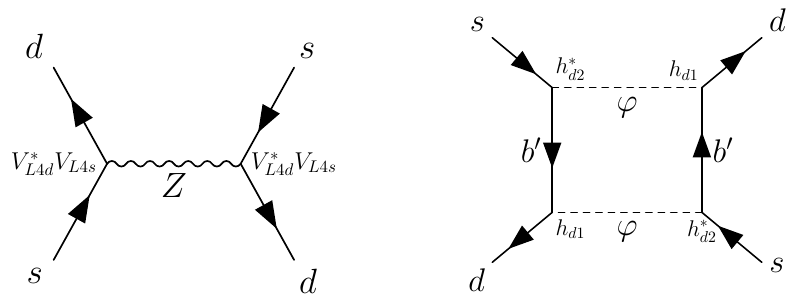
Figure 9 . Contributions to ¯ K 0 - K 0 transition due to the insertion of the additional vectorlike down-type weak isosinglet couple b 0